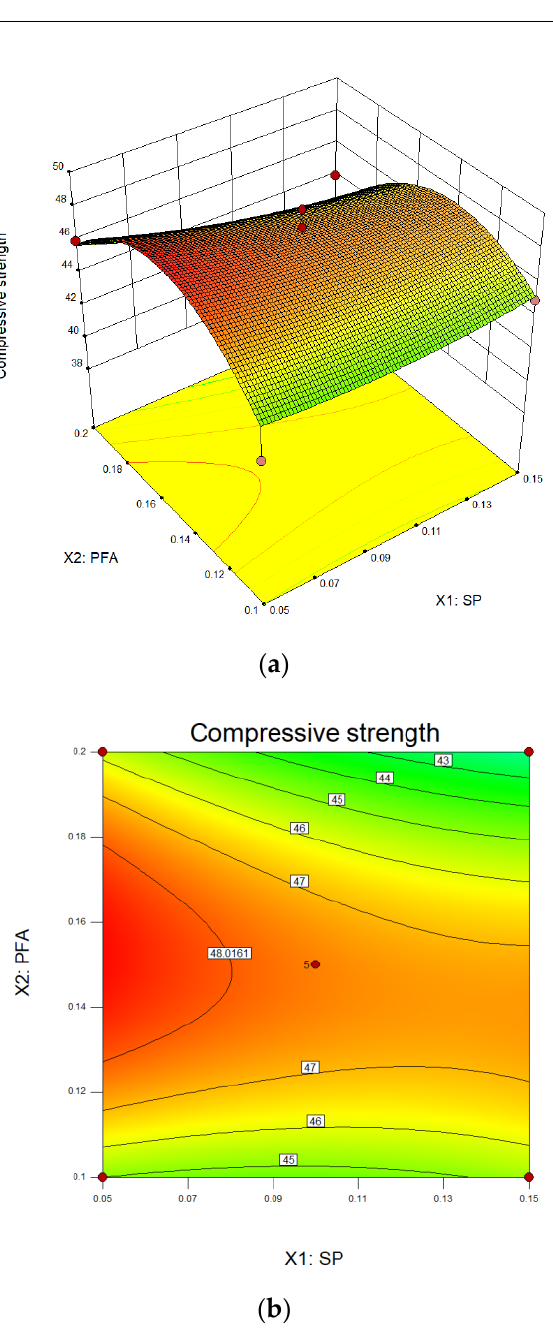
Figure 6. Response surface and contour in SP-PFA. ( a ) Response surface. ( b ) Contour.